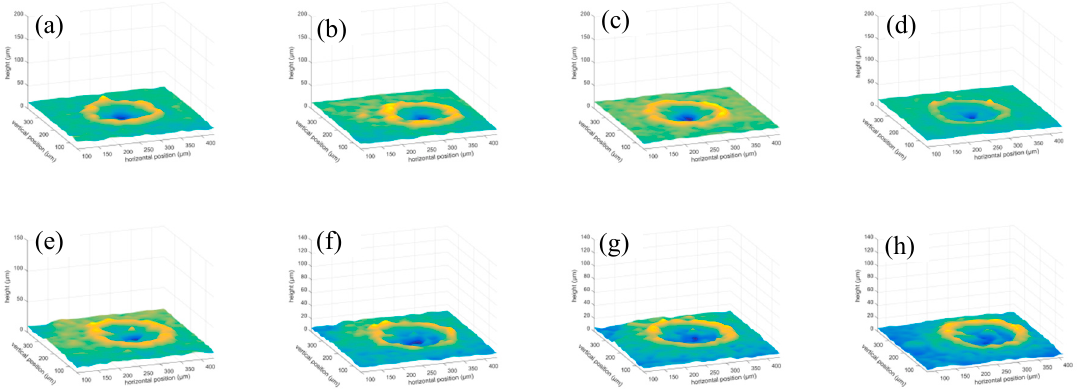
Figure 9. Top-view optical microscope images of ablation craters after irradiation of 4 pulses at substrate temperatures of 50–400 ◦ C. ( a ) 50 ◦ C; ( b ) 100 ◦ C; ( c ) 150 ◦ C; ( d ) 200 ◦ C; ( e ) 250 ◦ C; ( f ) 300 ◦ C; ( g ) 350 ◦ C; ( h ) 400 ◦ C.